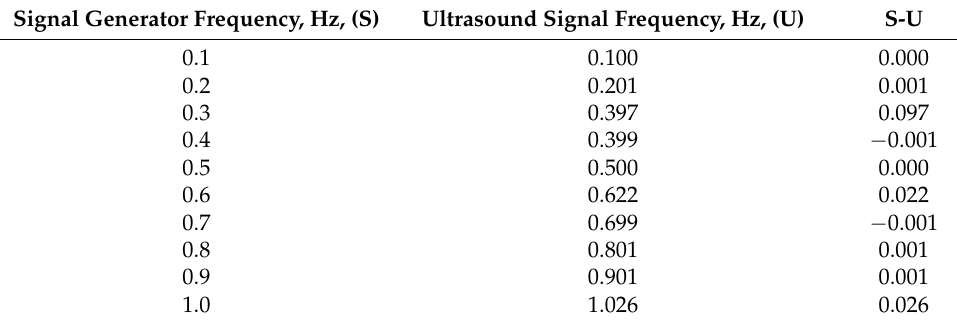
Table 1 provides the signal generator frequency varied in the range of 0.1 to 1 Hz (corresponding to a breathing range 0.1 Hz × 60 s = 6 bpm to 1.0 Hz × 60 s = 60 bpm) and the associated US signal frequencies determined by identifying the frequency corresponding to the peak in the signal’s magnitude frequency spectrum. Table 1. The signal generator and US signal frequencies. Signal Generator Frequency, Hz, (S)